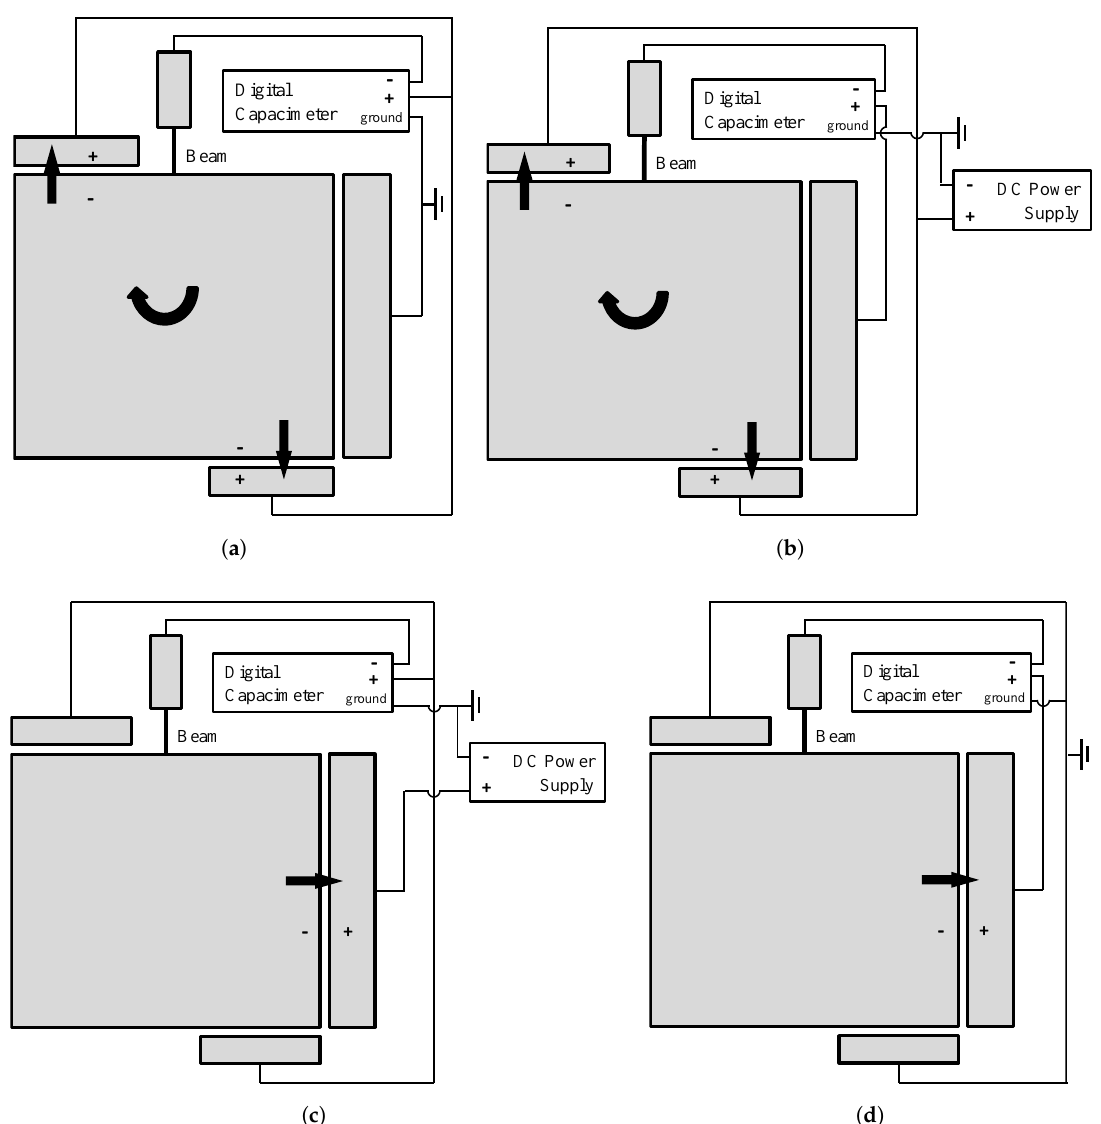
Figure 2. Adopted experimental set-ups: ( a ) RR configuration (rotational actuation and sensing); ( b ) RL configuration (rotational actuation, lateral sensing); ( c ) LR configuration (lateral actuation, rotational sensing); and ( d ) LL configuration (lateral actuation and